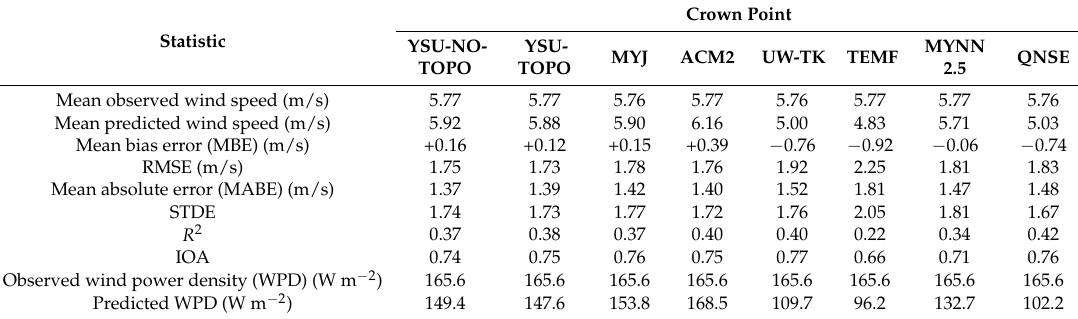
Table 3. Error statistics for wind speed and wind direction at the 10 m height above ground, and an estimate of the monthly wind power density for April 2003 at Crown Point. Error statistics were computed for 720 h of simulated winds. Crown Point Statistic YSU-NO- MYNN UW-TK TEMF TOPO